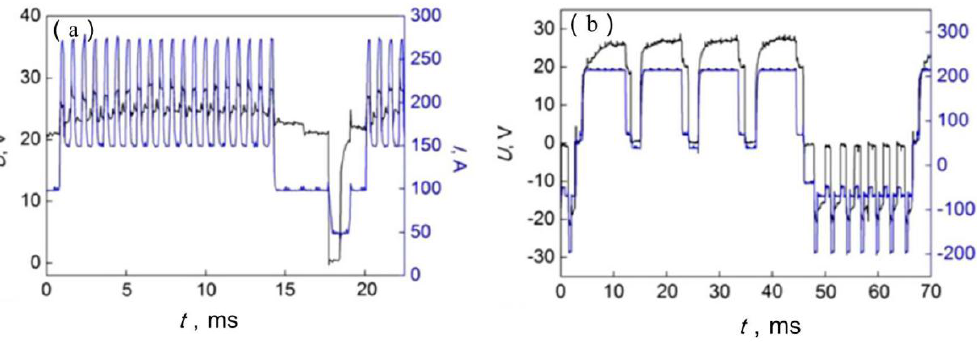
Figure 2. Actual arc current and voltage waveforms of ( a ) CMT-P and ( b ) CMT-ADV. Table 1. Nominal compositions of ER2319 wire and 2219-T87 substrate.